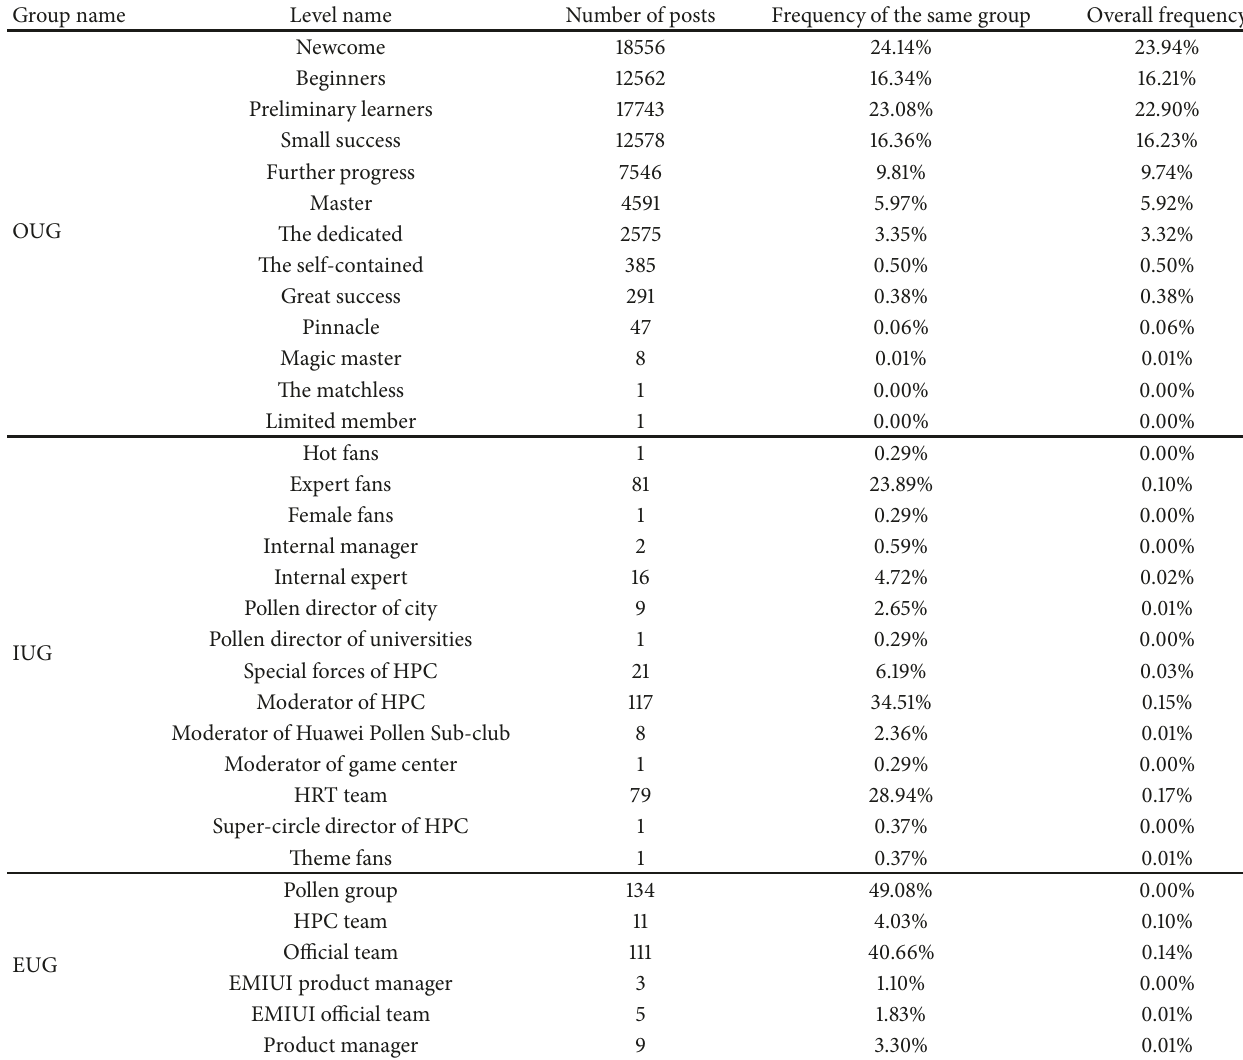
Table 8: Related statistics of valid posts of corresponding user.